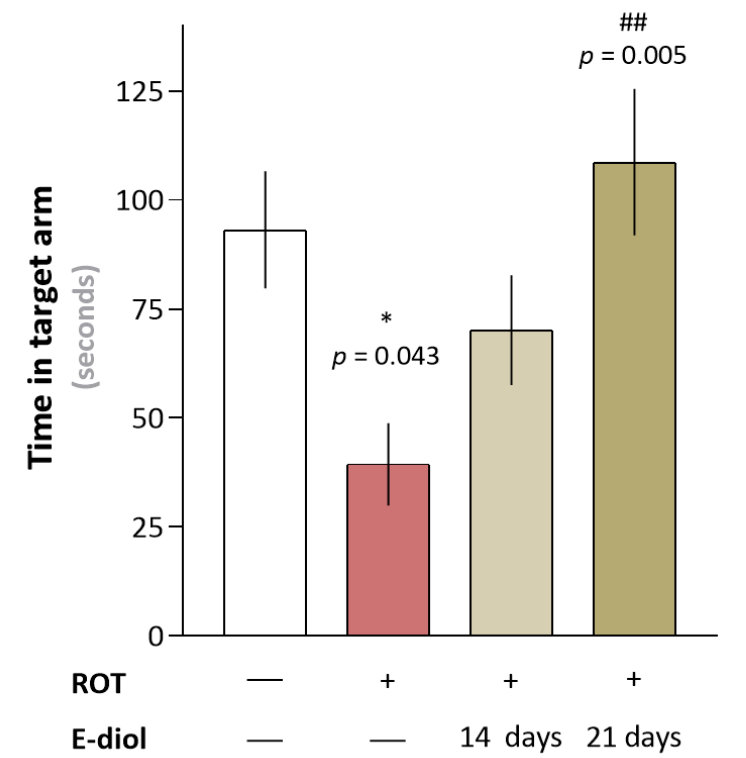
Figure 8. In vivo study of the epoxidiol (E-diol) effect on the formation of short-term spatial memory in C57BL/6J mice aged 3 months under conditions of rotenone-induced (ROT) neurotoxicity. The data are presented as graphs in which each column represents the average time spent by an independent mice group in the correct arm of the maze (mean ± SEM). To assess the statistical significance, one-way ANOVA and Bonferroni’s multiple comparison tests were used, where * p ≤ 0.05 versus control; ## p ≤ 0.01 versus